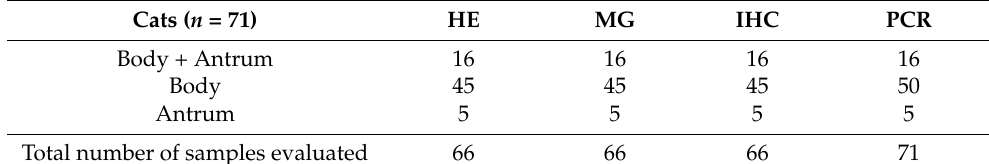
Table 1. Gastric samples subjected to evaluation with different methods. Cats ( n = 71) HE MG IHC PCR Body + Antrum 16 16 16 16 Body 45 45 45 50 Antrum 5 5 5 5 Total number of samples evaluated 66